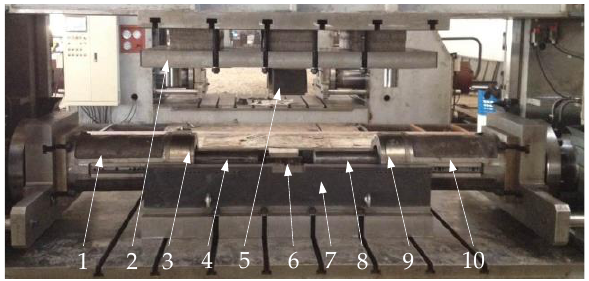
Figure 28. PPDR dies. 1. Left support cylinder; 2. Upper die base; 3. Left reducing die; 4. Left man- drel; 5. Upper clamping die; 6. Lower clamping die; 7. Lower die base; 8. Right mandrel; 9. Right reducing die; 10. Right support cylinder.